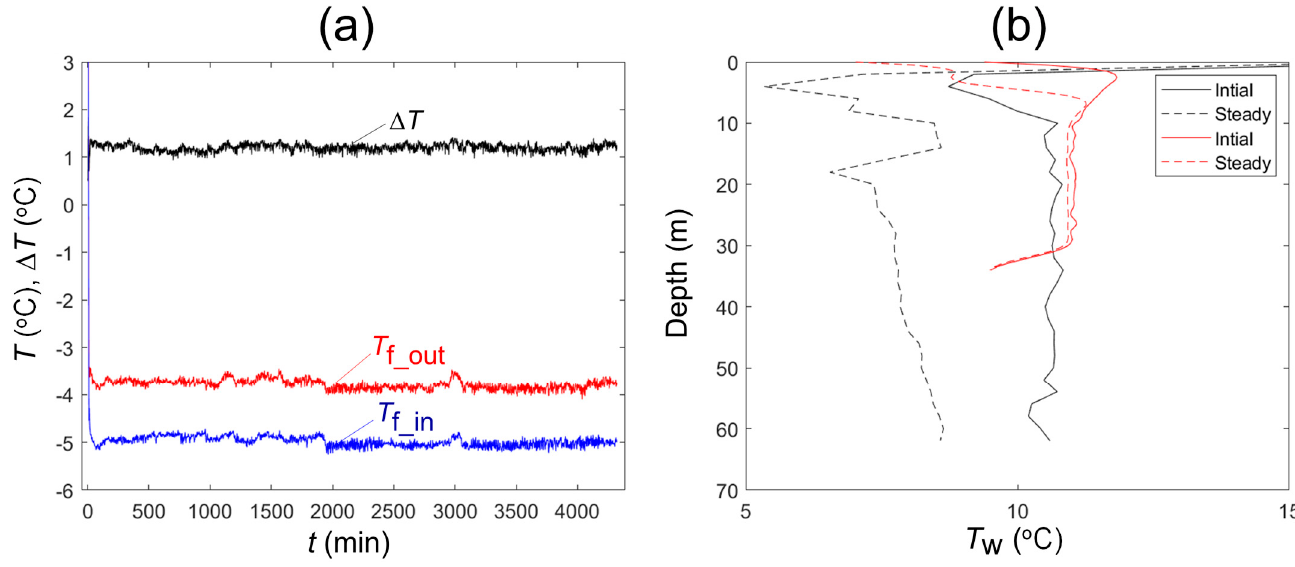
Figure 6. Example of temperature observations, testing inlet temperatures T f_in , outlet temperature T f_out , and their difference ∆ T at a set temperature T in of − 5 ◦ C at Site 1 for a single heat pipe system ( a ) and temperature profiles with measurement depth before and during steady-state single-heat-pipe heat extraction at Site 1 and 2 ( b ).